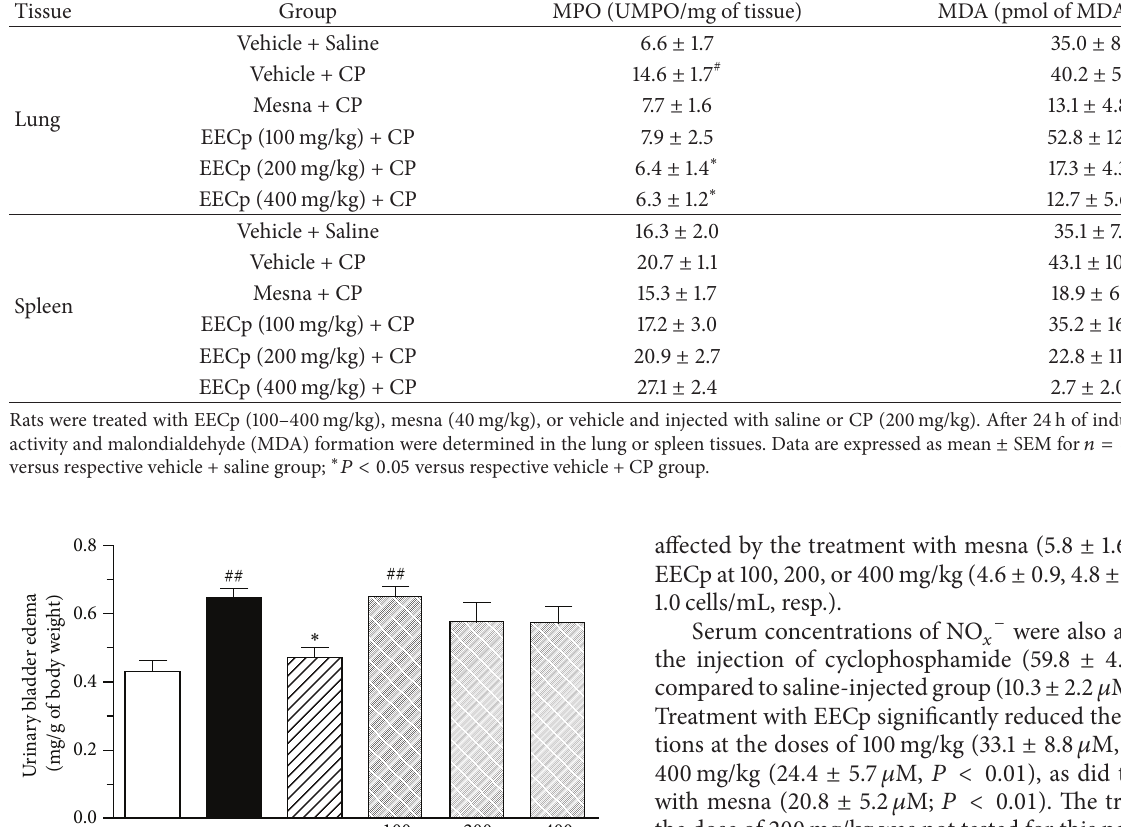
Table 1: Effect of the ethanol extract of Caesalpinia pyramidalis (EECp) on the myeloperoxidase (MPO) activity and lipid peroxidation of lung and spleen of rats during cyclophosphamide (CP)-induced cystitis.